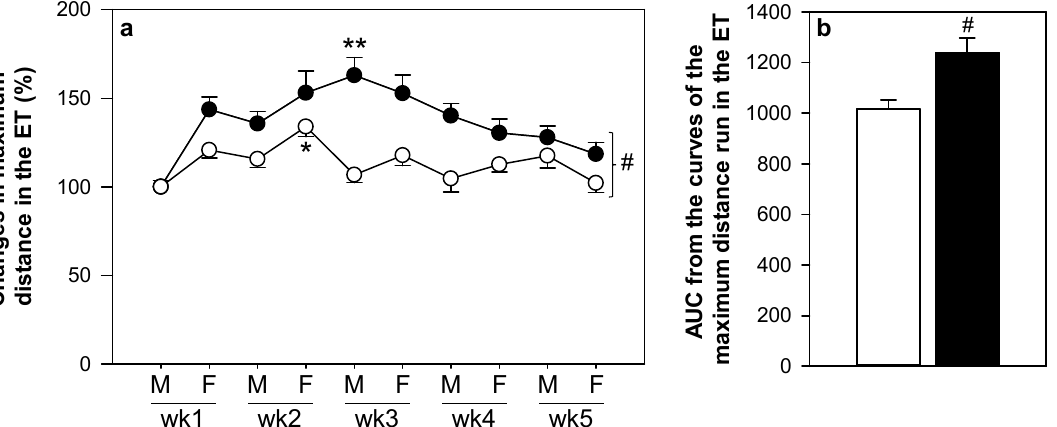
Figure 2. Changes in maximum distance run in the exhaustion tests throughout the study in percentage in comparison with the first day ( a ), and AUC from these curves showing changes in maximum distance run in the exhaustion tests ( b ). AUC = area under the curve, ET = exhaustion test, M = Monday, F = Friday, wk = week. The non-supplemented group is represented by white symbols and bars, and the hesperidin group by black symbols and bars. Data are expressed as mean ± SEM ( n = 22–23). Statistical difference: * p < 0.001 in the non-supplemented group vs. the first and the last day (peak of performance); ** p < 0.001 in the hesperidin group vs. the first and the last day (peak of performance); # p < 0.005 between non-supplemented and the hesperidin-supplemented groups (Student’s t -test).